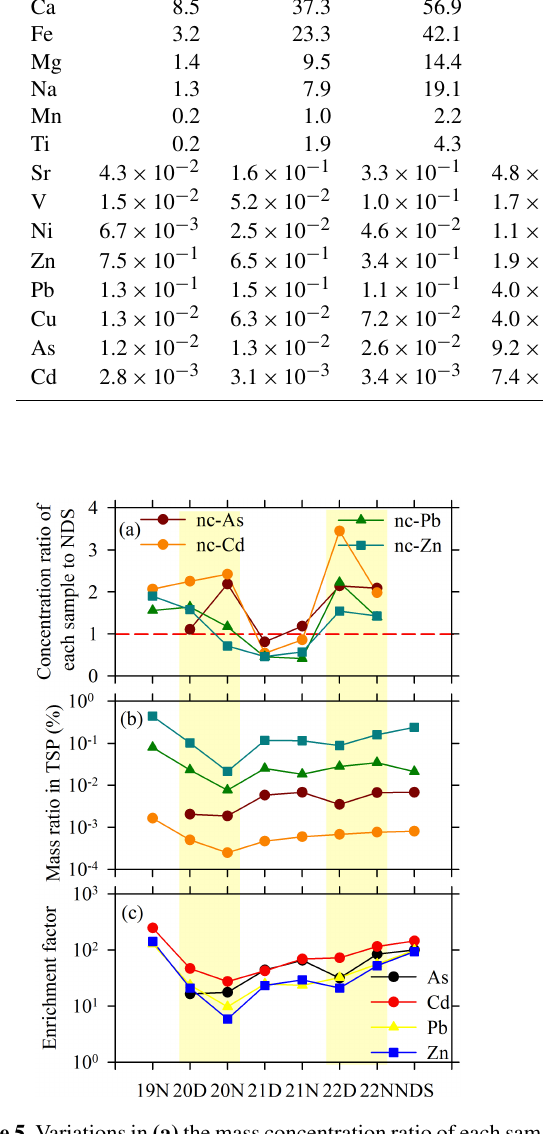
Figure 5. Variations in (a) the mass concentration ratio of each sam- ple to the NDS sample for nc-As, nc-Cd, nc-Pb, and nc-Zn, (b) the mass ratios, and (c) enrichment factors of pollution elements As, Cd, Pb, and Zn in TSP during 19–22 March and non-dust (NDS) days. D, N, and NDS represent the daytime samples collected from 08:00 to 20:00LST, the nighttime samples collected from 20:00 to 08:00LST on the next day, and the average of the non-dust samples collected from 25 to 27 March,